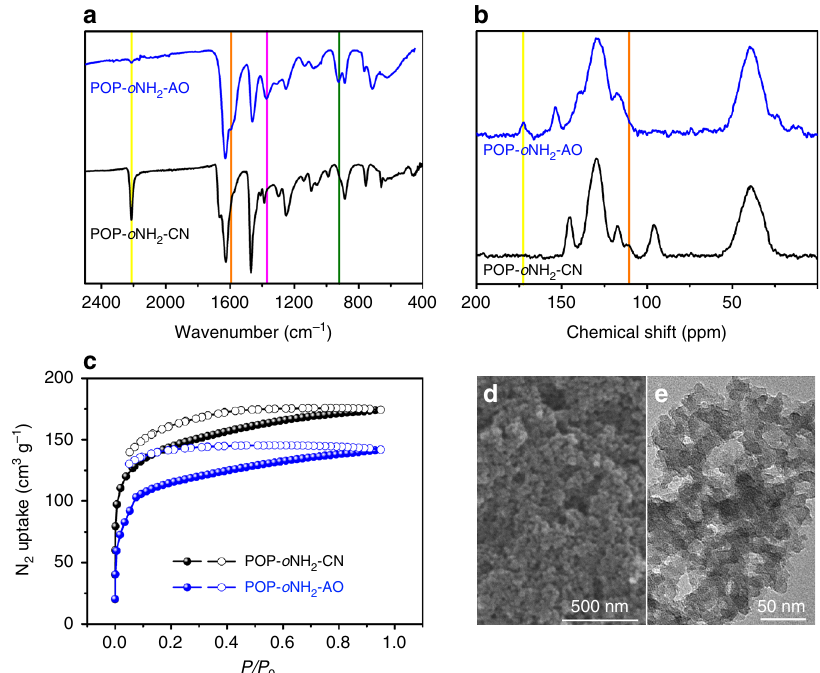
Fig. 1 Structural characterization. a FT-IR spectra, b 13 C CP/MAS NMR spectra, c N 2 sorption isotherms, and d , e SEM and TEM images for POP- o NH 2 -AO,